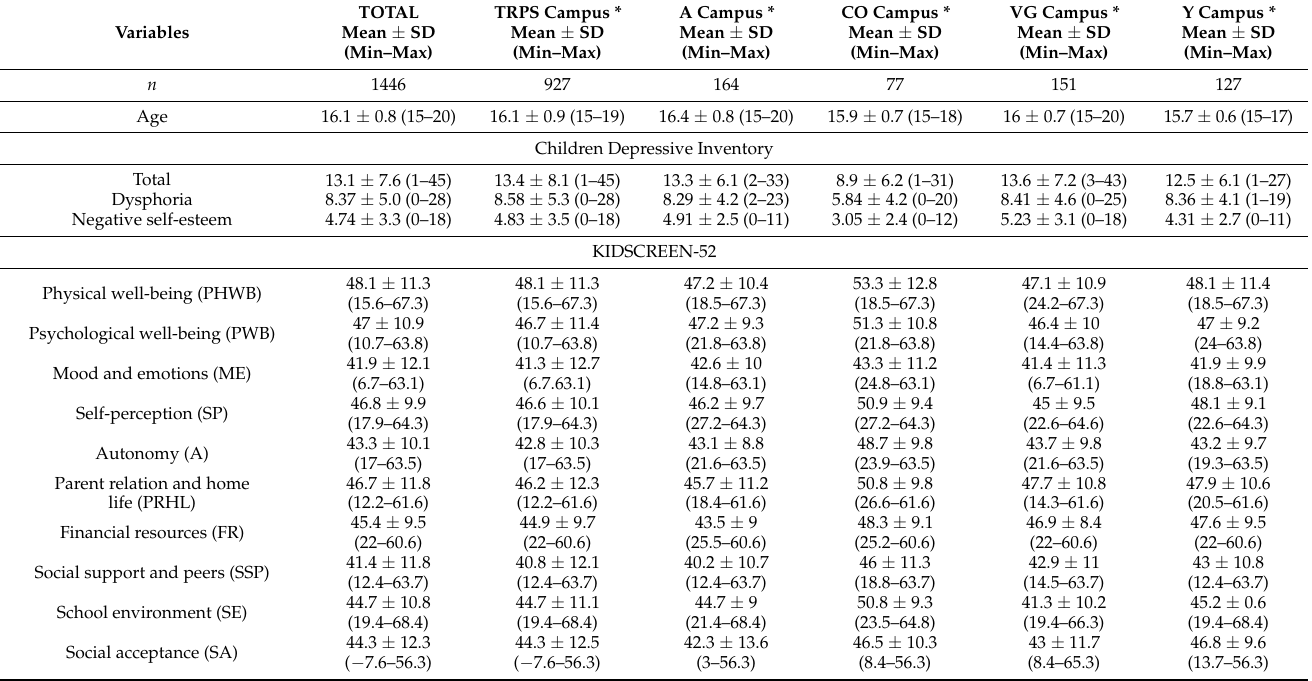
Table 1. Psychometric characteristics of the sample ( n = 1446), stratified by